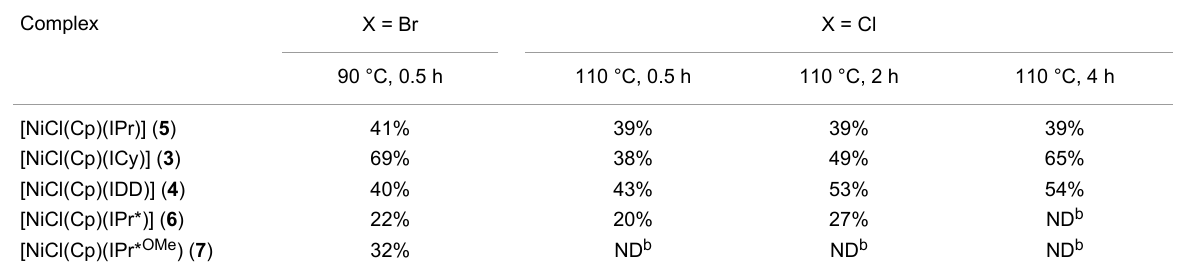
Table 3: Results of test reactions with 4’-bromo- and 4’-chloroacetophenone, conducted using the conditions detailed in Scheme 4. a